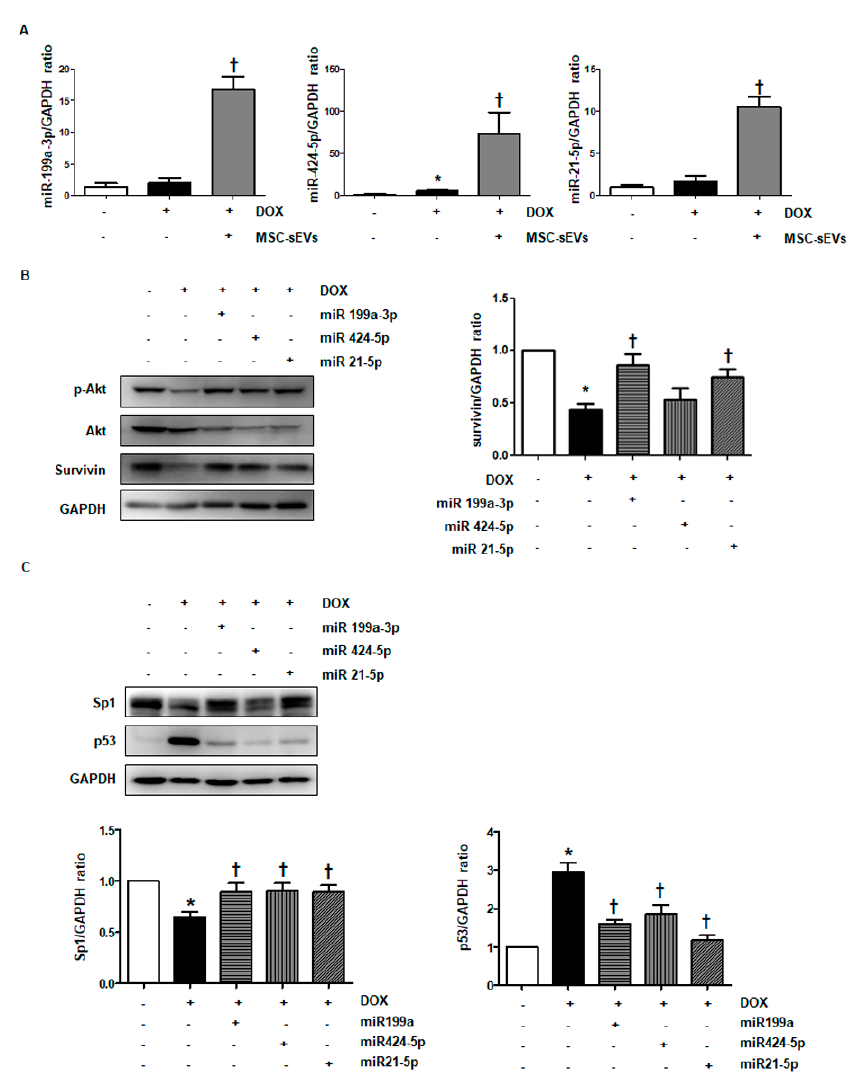
Figure 6 . MiR − 199a − 3p and miR − 21 − 5p in MSC − sEVs are involved in regulating the Akt − Sp1/p53 − survivin axis in DOX − treated cardiomyocytes. ( A ) H9c2 cells were pretreated with MSC − sEVs (3 × 10 9 ) for 24 h and then incubated with DOX (1 μ M) for 24 h. The levels of miR199a − 3p, miR424 − 5p and miR21 − 5p were measured by qPCR ( n = 5). * Significant difference compared to the control ( p < 0.05). † Significant difference compared to DOX treatment ( p < 0.05). ( B , C ) H9c2 cells transfected with three miRNA mimics were incubated with DOX for 24 h. The protein levels of p − Akt, Akt, survivin, Sp1, p53 and GAPDH were measured by Western blotting ( n = 5). * Significant difference compared to the control ( p < 0.05). † Significant difference compared to DOX treatment ( p < 0.05).